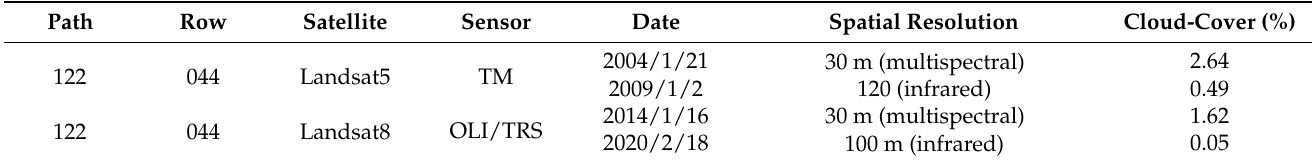
Table 1. Remote sensing data used in this study.